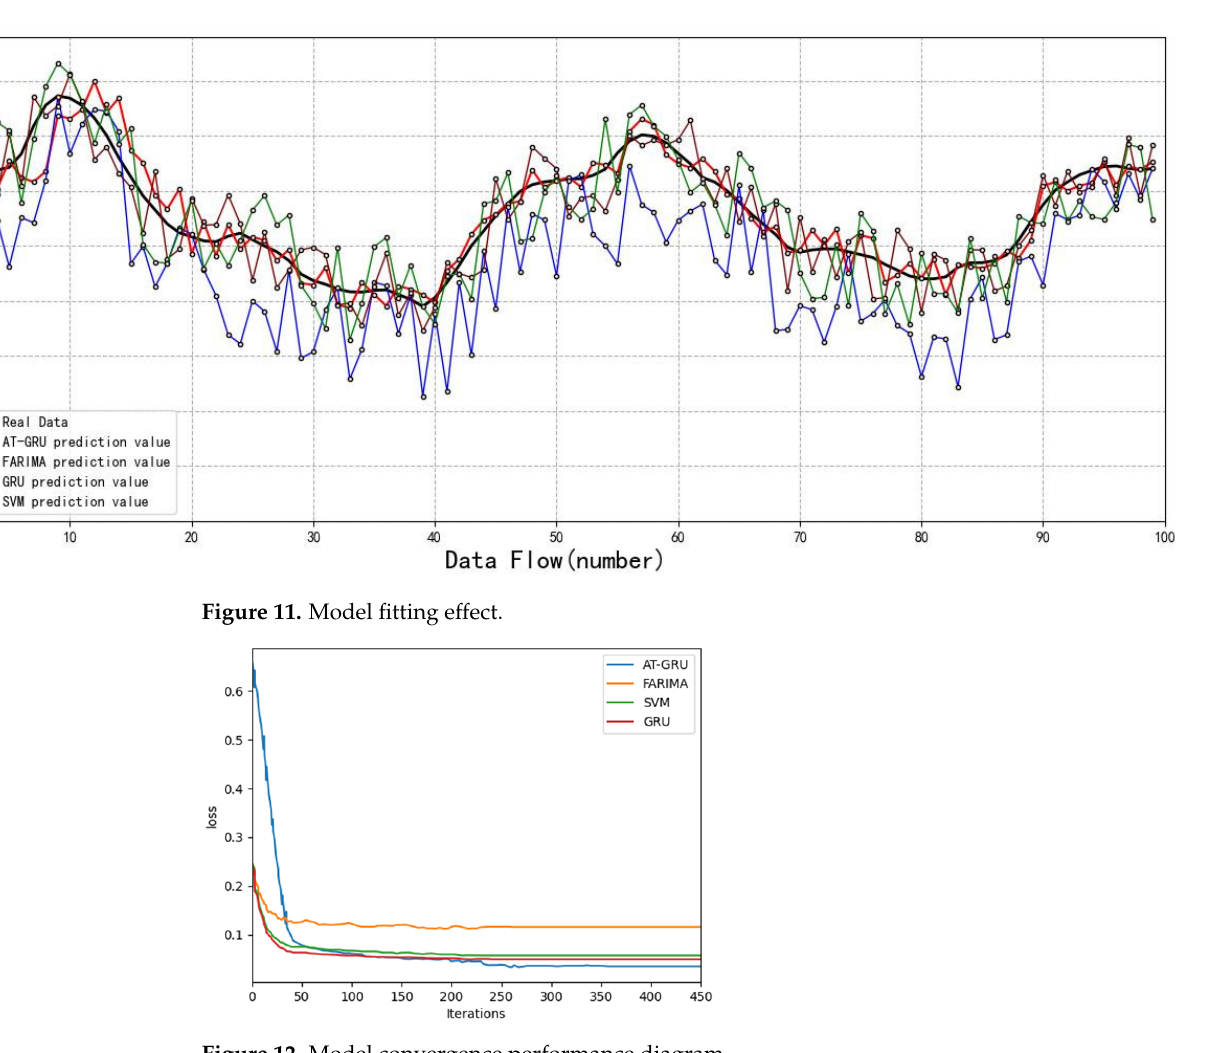
Figure 12. Model convergence performance diagram. Table 2. Error comparison of different